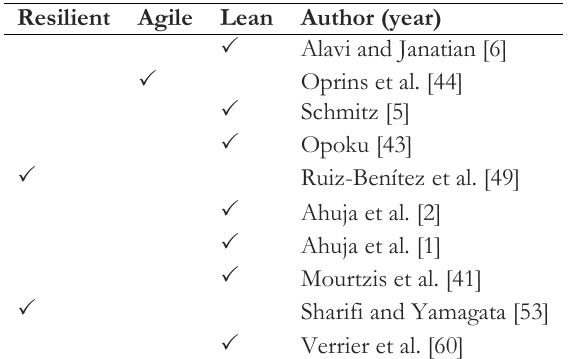
Table 4. Studies related to lean, agile and resilient dimensions in green project management.